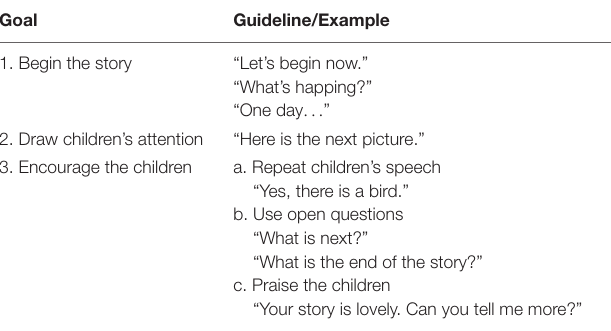
TABLE 1 | Instructions for experimenters in the narrative elicitation